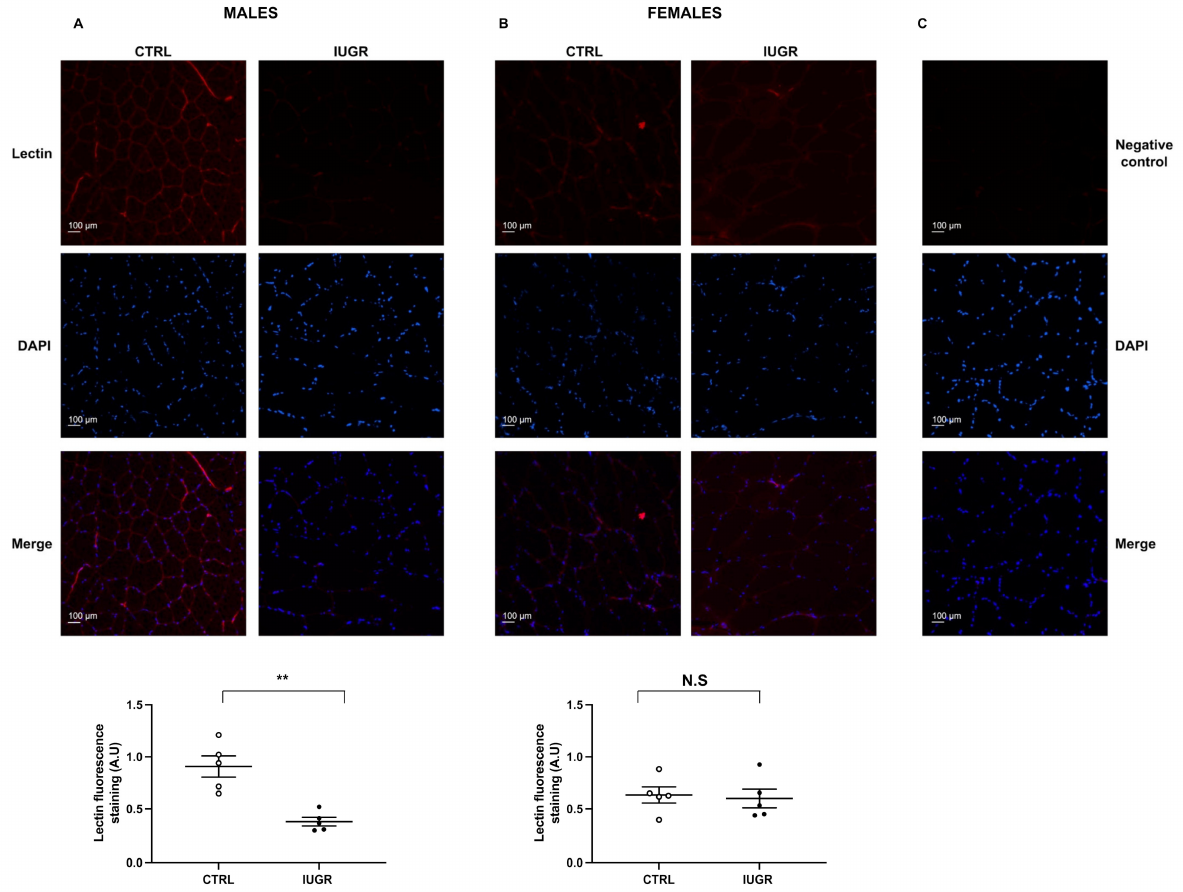
Figure 1. Microvascular density measurement. Capillary density was assessed in the anterior tibialis muscle of CTRL and IUGR males ( A ) and females ( B ) at six months of life using lectin-TRITC staining. Nuclei were counterstained with DAPI, and a negative control was performed ( C ). Magnification (20 × ); n = 5 animals/group; ** p < 0.01. N.S: not significant. Scale bar = 100 µ